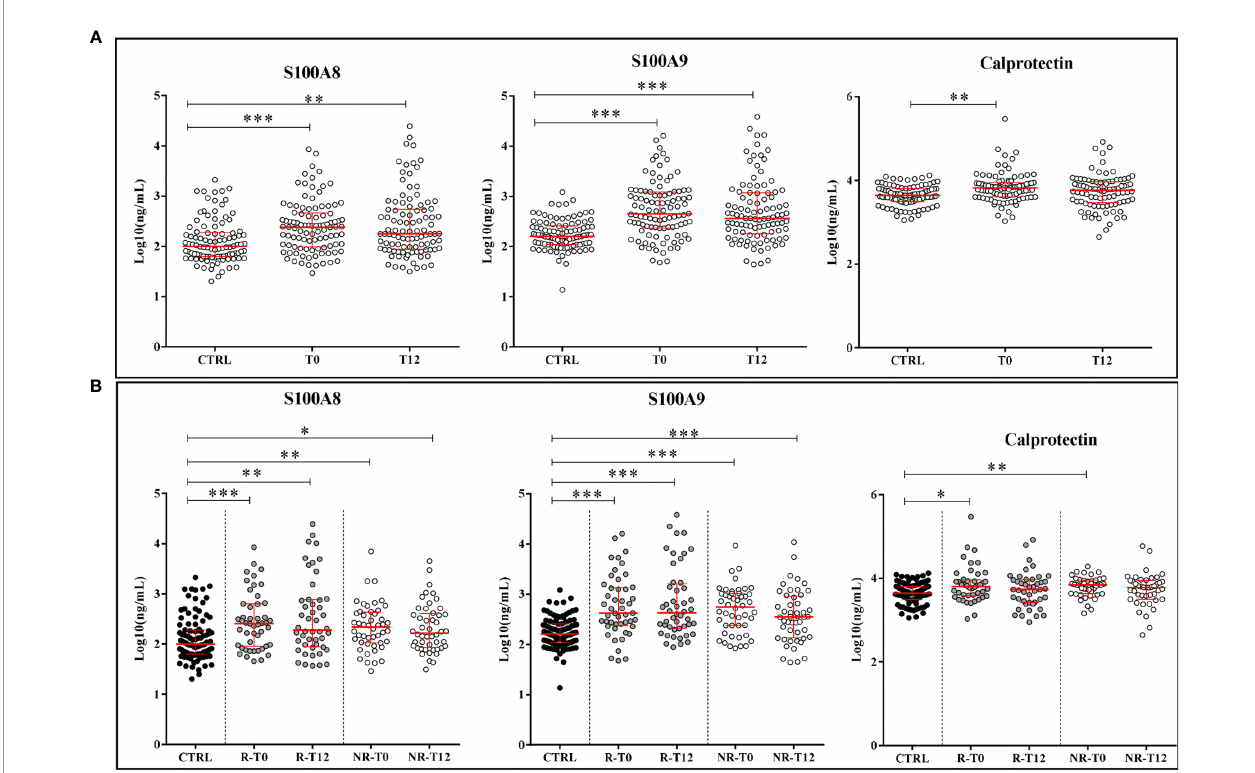
FIGURE 3 | Quanti fi cation of proteins S100A8, S100A9, and calprotectin. (A) Expression of alarmins in controls (CTRL) and ERA patients at time T0 and after 12 months of treatment (T12). (B) Variation of the expression of alarmins in good (R) and non-responders (NR). Scatter dot plots represent the median with interquartile range. *p-value ≤ 0.05, **p-value ≤ 0.01, ***p-value ≤ 0.001 (Kolmogorov – Smirnov